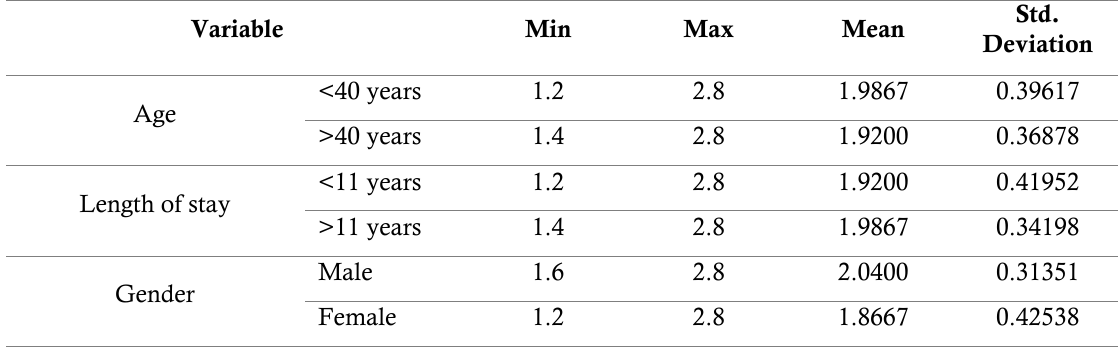
Table 2 Descriptive Statistical Test Results for Behavioral Factors Disposing of Garbage in